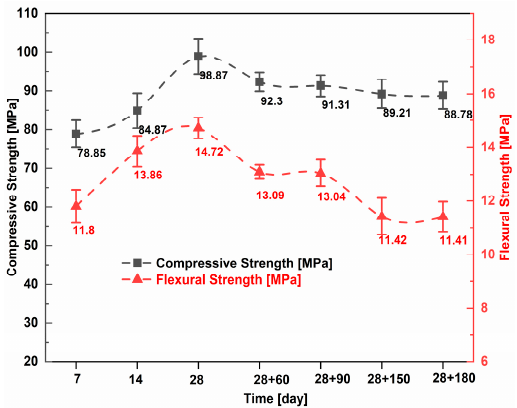
Figure 5. Development of the mechanical strength of geopolymer mortar.